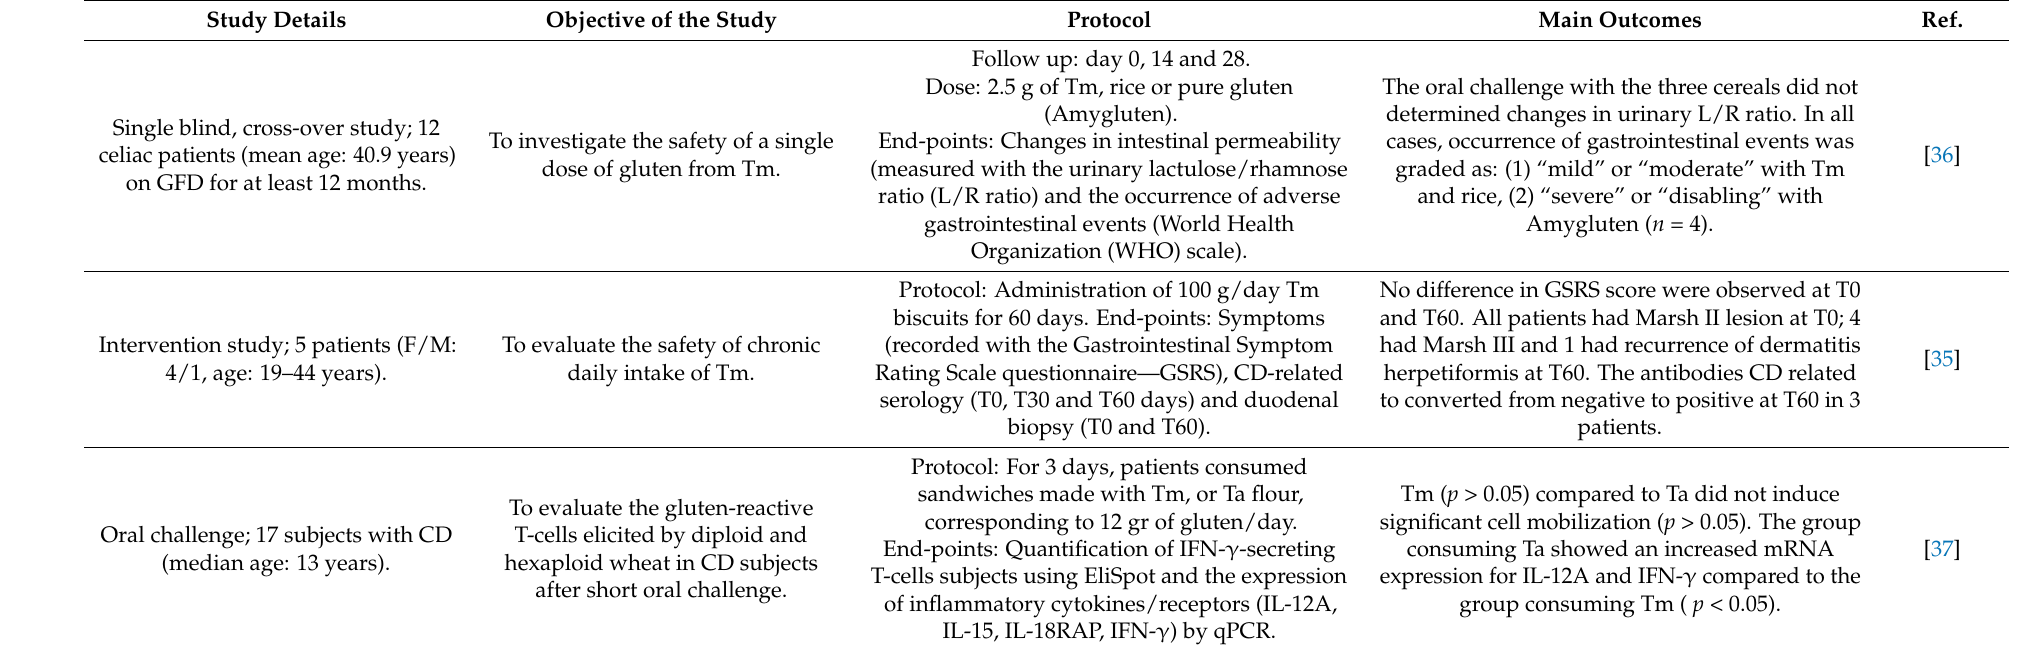
Table 5. In vivo studies to evaluate the toxicity of T. monococcum for celiac